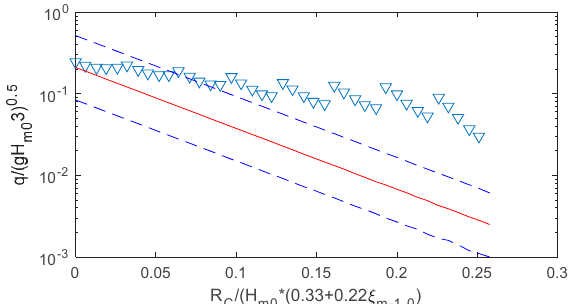
Figure 13. Comparison to Van Gent [4] (red solid line: prediction using mean value approach of Van Gent; dashed line: 5% under- and upper-exceedance limits; and triangle: SWASH values).